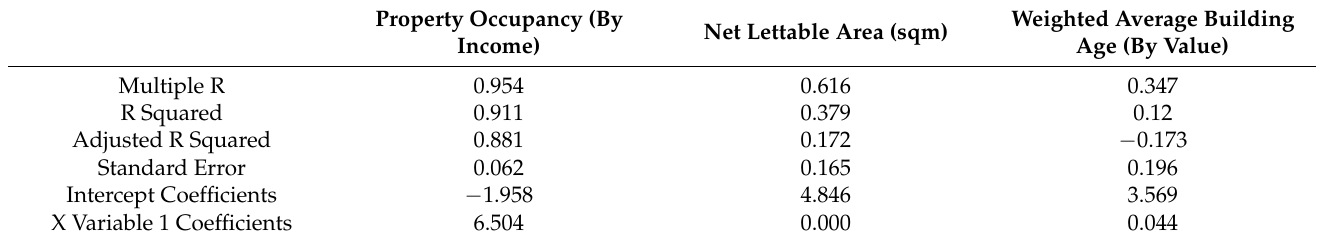
Table 6. Regression results of direct property asset features.